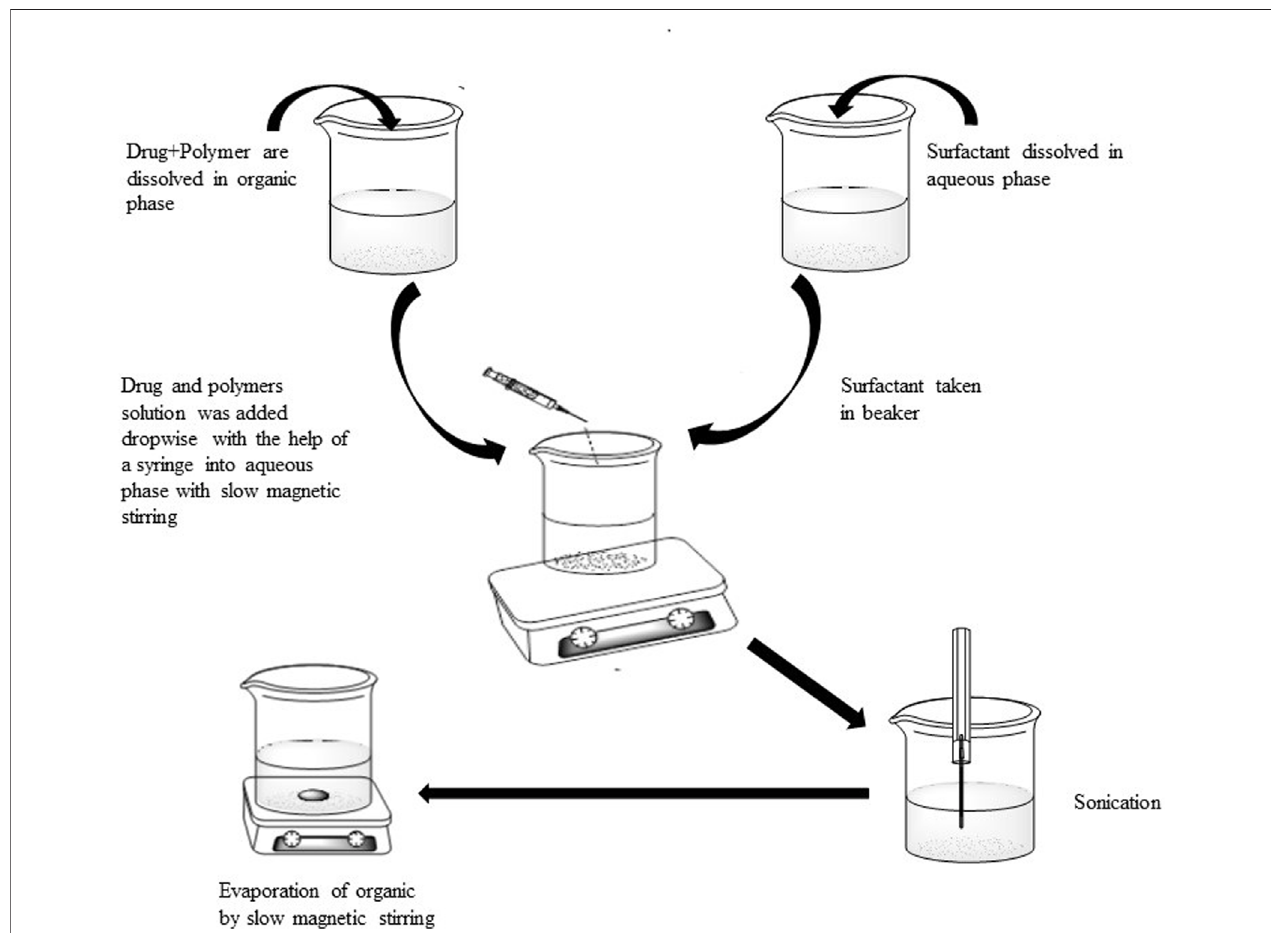
Frontiers in Pharmacology |